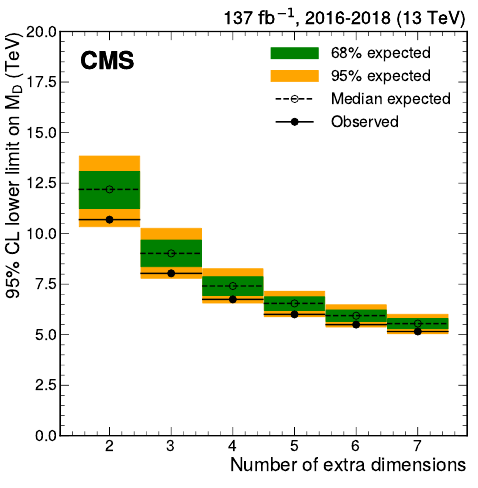
in the ADD scenario for different values of the D